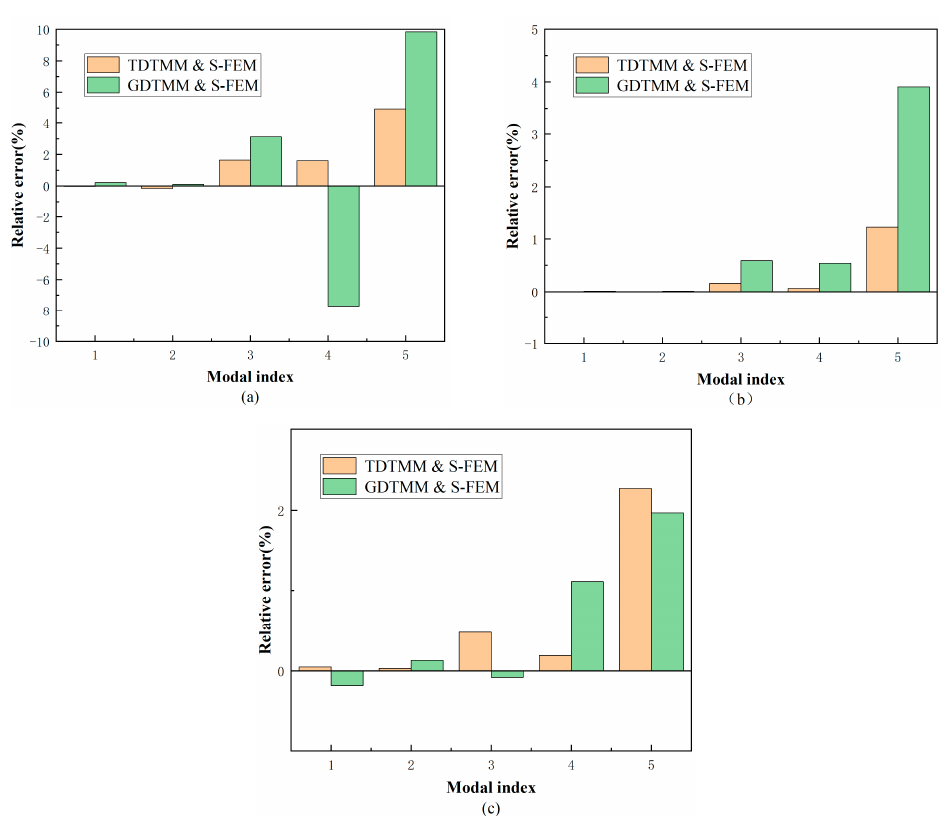
Figure 7. The plot of relative error on natural frequencies versus modal index for example 2 under different boundary conditions: ( a ) C-C; ( b ) C-F; ( c ) F-F.